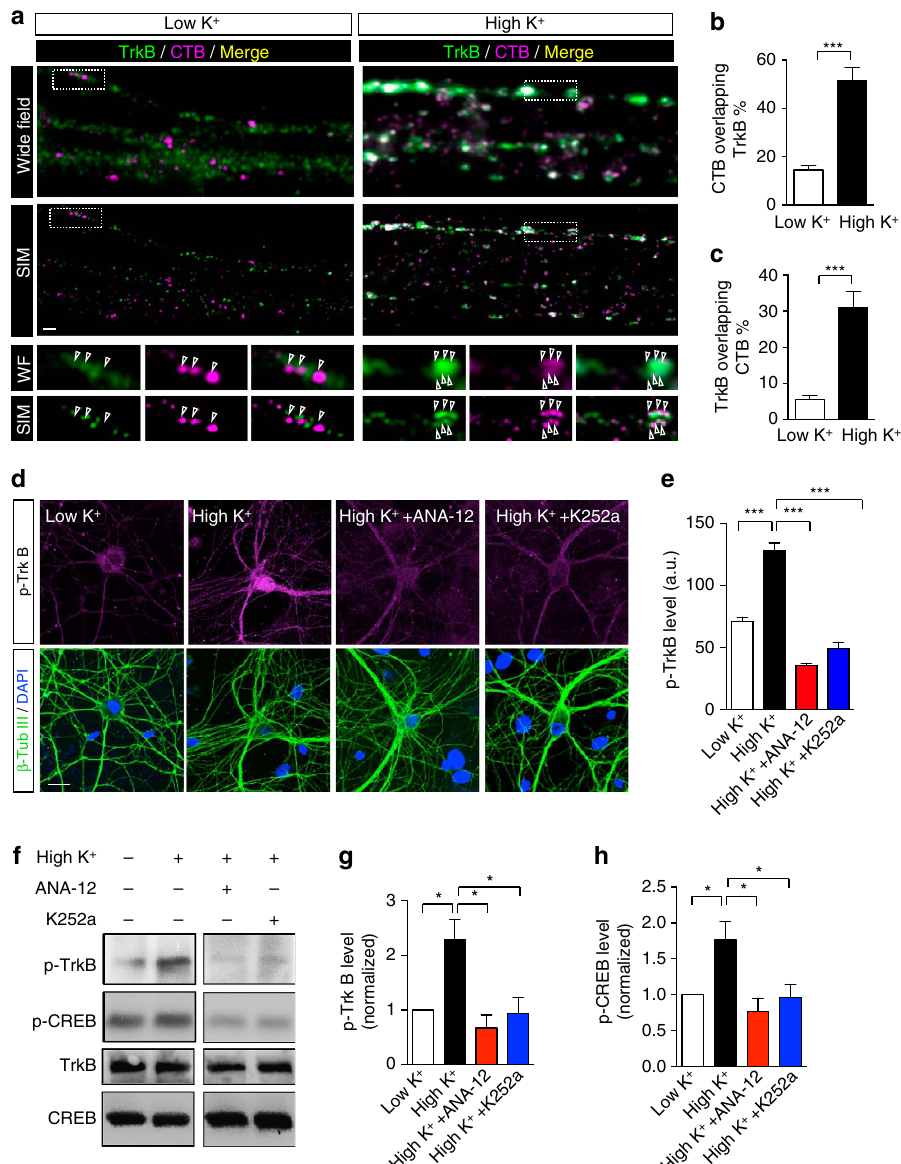
Figure 5 | Activation of TrkB controls the activity-induced increase in CTB retrograde flux. ( a ) Representative wide-field and SIM images of axons in microfluidic chambers that were labelled with CTB (magenta) under either low K þ (left) or high K þ (right) conditions. TrkB antibody (green) was used to label endogenous TrkB receptors. Boxed regions magnified in the lower panels, and aligned CTB vesicles are pointed out with arrowheads. Scale bar, 1 m m. ( b , c ) Quantification of the ratio of CTB overlapping with TrkB ( b ), and the ratio of TrkB overlapping with CTB ( c ) from SIM images. (Mander’s coefficient, mean ± s.e.m., n ¼ 39 (low K þ ) or n ¼ 46 (high K þ ) channels from three independent neuron preparations. *** P o 0.001, Student’s t -test). ( d ) Activation of th TrkB pathway was examined with an antibody against phosphorylated Tyr 707/706 of TrkB receptors (top panels). Pretreatment with 0.5 m M ANA-12 or 100nM K252a for 30min significantly inhibited the high K þ -induced p-TrkB increase; b -tubulin III and DAPI (bottom panels) were used to show the density of neuron layers. Scale bar, 20 m m. ( e ) Quantification of d . (mean ± s.e.m., n ¼ 29 (low K þ ) or 30 (high K þ ) channels from three independent neuron preparations. *** P o 0.001, Student’s t -test). ( f ) Western blot of DIV 14 hippocampal neurons pretreated with 0.5 m M ANA-12 or 100nM K252a for 30min showing the same abolition of the high K þ induced increase in p-TrkB and phosphorylated CREB protein (p-CREB), which represented the downstream response; total TrkB and CREB protein levels were used as controls. ( g – h ) Quantification of f . (mean ± s.e.m., n ¼ 3, data from three independent cultures, * P o 0.05, Student’s t